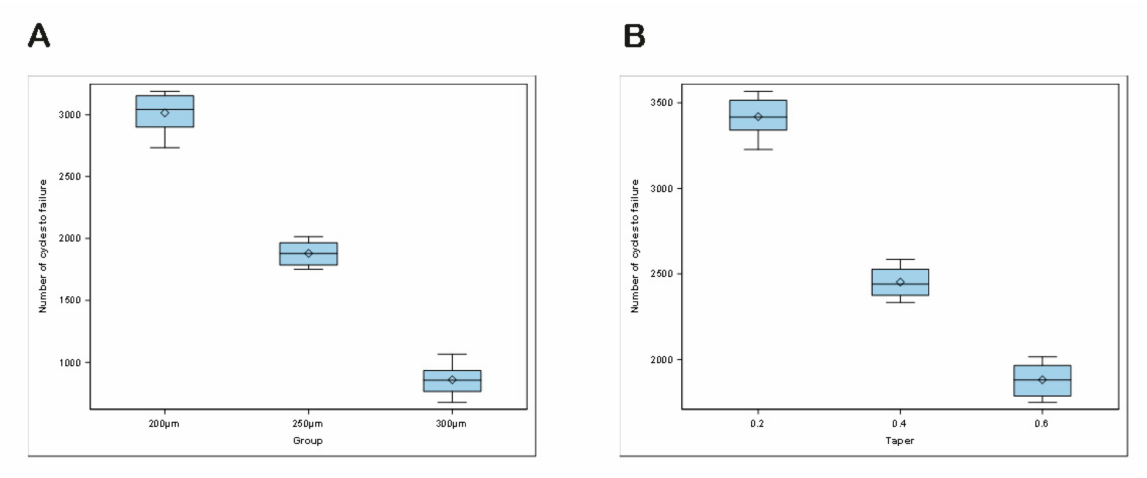
Figure 7. Box plots of the number of cycles to failure for the ( A ) apical diameter and ( B ) taper study groups. The horizontal line in each box represents the median value.